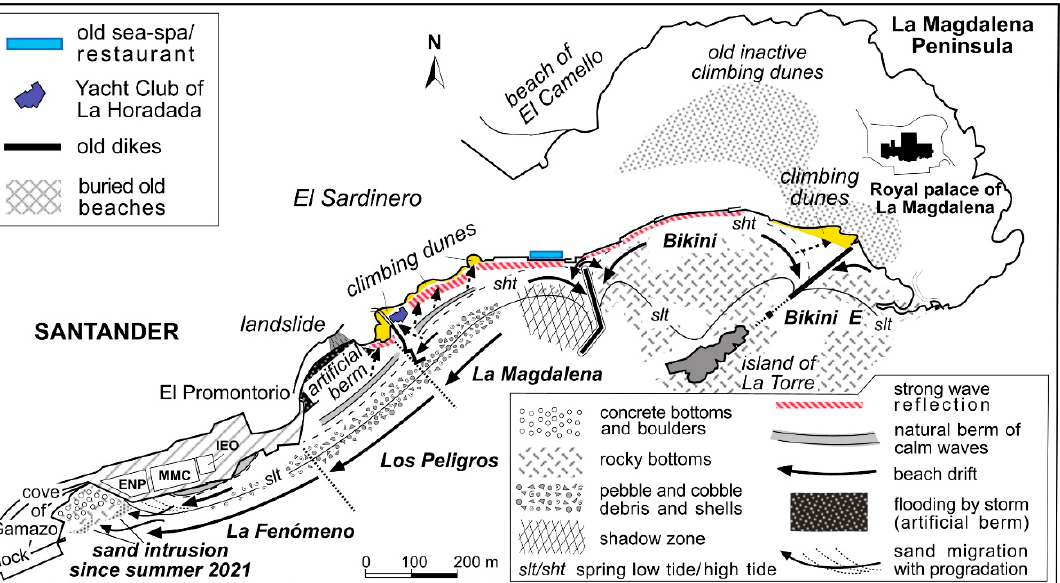
Figure 10. Morphodynamic conceptual model after the construction of the breakwater (2018), high- lighting the following main processes: reflection in the upper beach during storm, which has only been artificially recovered; westward beach drift; and aeolian transport to the small outcrops of climbing dunes mainly of Los Peligros and La Magdalena. The former cove of Gamazo, with calcareous and concrete bottoms and boulders, is turning into a sandy beach.